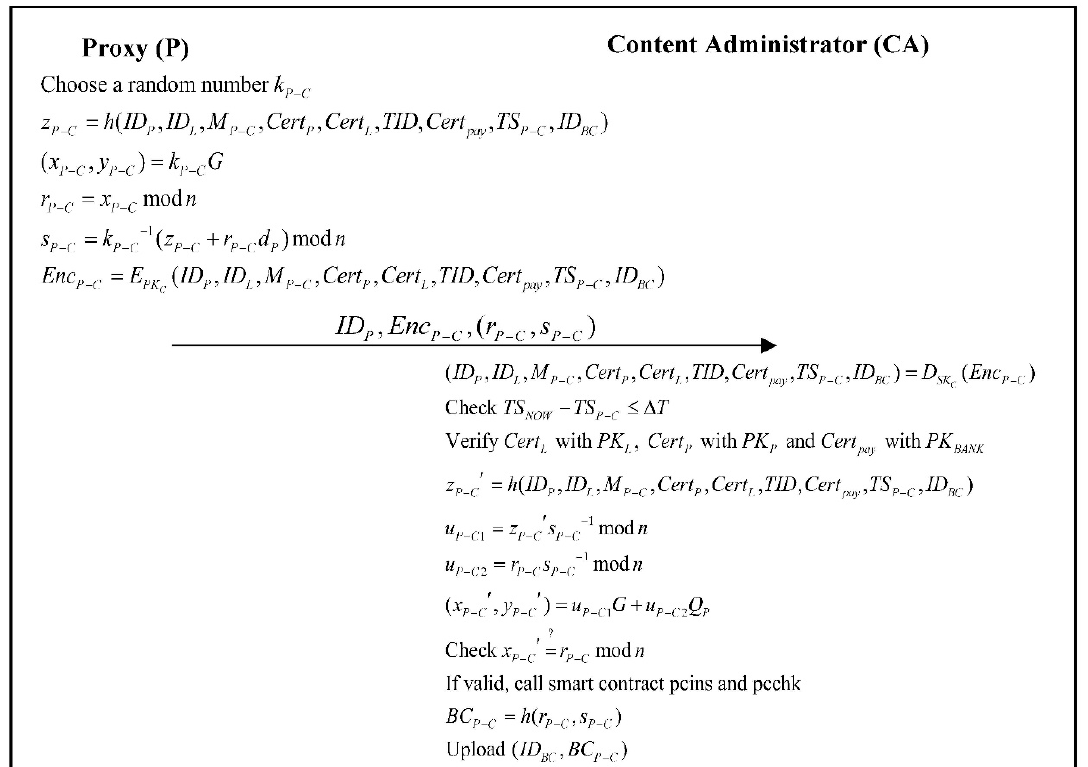
Figure 13. Payment verification and browsing phase (P to CA).